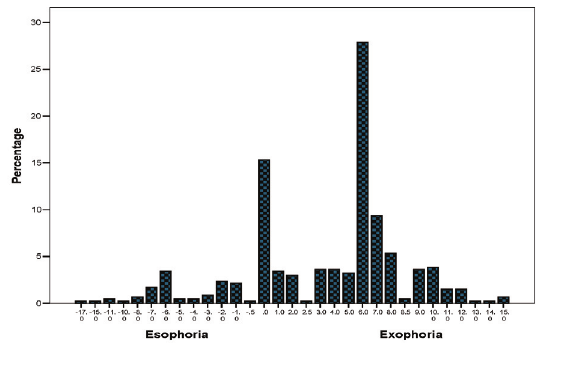
Figure 2 Distribution of horizontal heterophoria for near vision for the total sample, showing greater proportion of exo- phoria and the peak is at 6 pd exophoria.